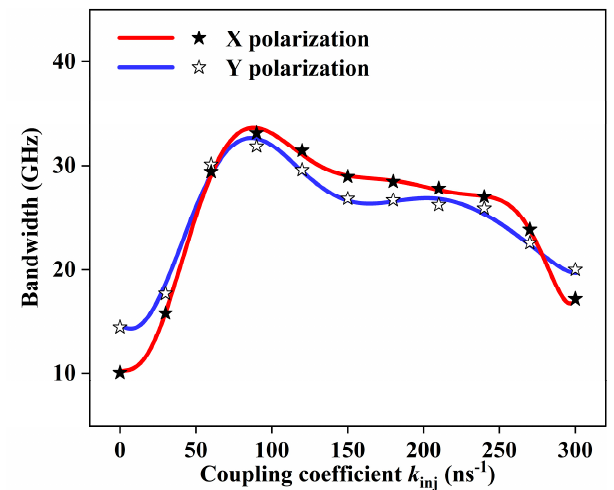
Figure 7. The variation of polarization chaos bandwidth for XP and YP modes of VCSEL1 with the coupling